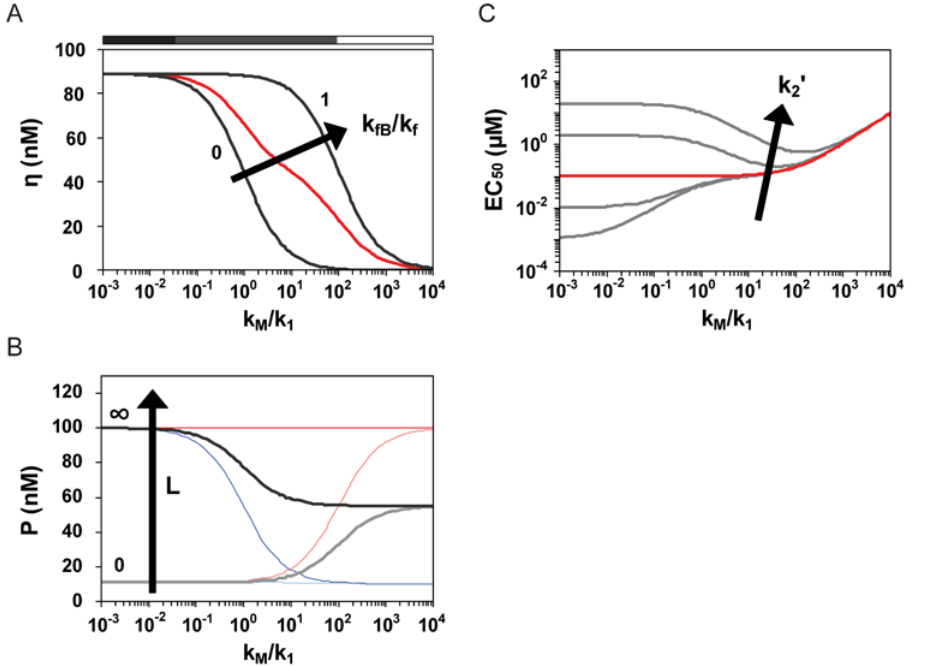
Figure 3. Rate competition dictates riboswitch performance. The relative values of the reversible and irreversible rate constants generally establish three operating regimes: thermodynamically-driven ( & ) when reversible rate constants dominate, kinetically-driven ( & ) when the rate constants are balanced, and non-functional ( % ) when irreversible rate constants dominate. Regimes are qualitatively marked for dynamic range and basal and ligand-saturating levels according the ratio of the rate constants for terminator stem formation (k M ) and the progression from conformation A to conformation B (k 1 ). Effect of varying k M on (A) dynamic range, (B) basal protein levels and ligand-saturating protein levels, and (C) EC 50 for riboswitches functioning through transcriptional termination. In (B), colored pairs show basal (light) and ligand-saturating (dark) protein levels for complete (red), balanced (black), and negligible (blue) transcriptional folding into conformation B. Parameter values for all curves in (A) and (B) and the red curve in (C): k 1 =10 2 1 /s;k 1 9 =10/s; k 2 =10 6 /M ? s; k 2 9 =10 2 1 /s; K A =k P ? k MA /k M =10 2 3 /s; K B =k P ? k MB /k M =10 2 2 /s; k f =10 2 11 M/s; k dP =10 2 3